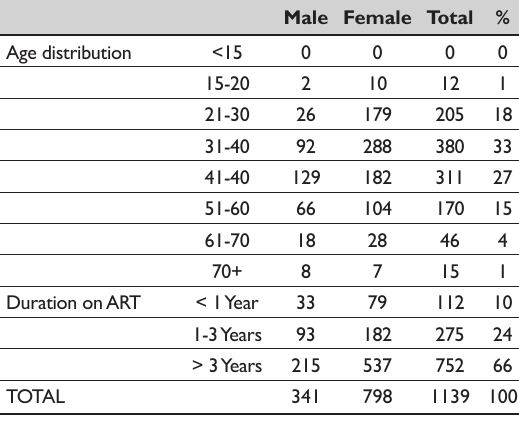
Table 1: Socio-demographic characteristics of study